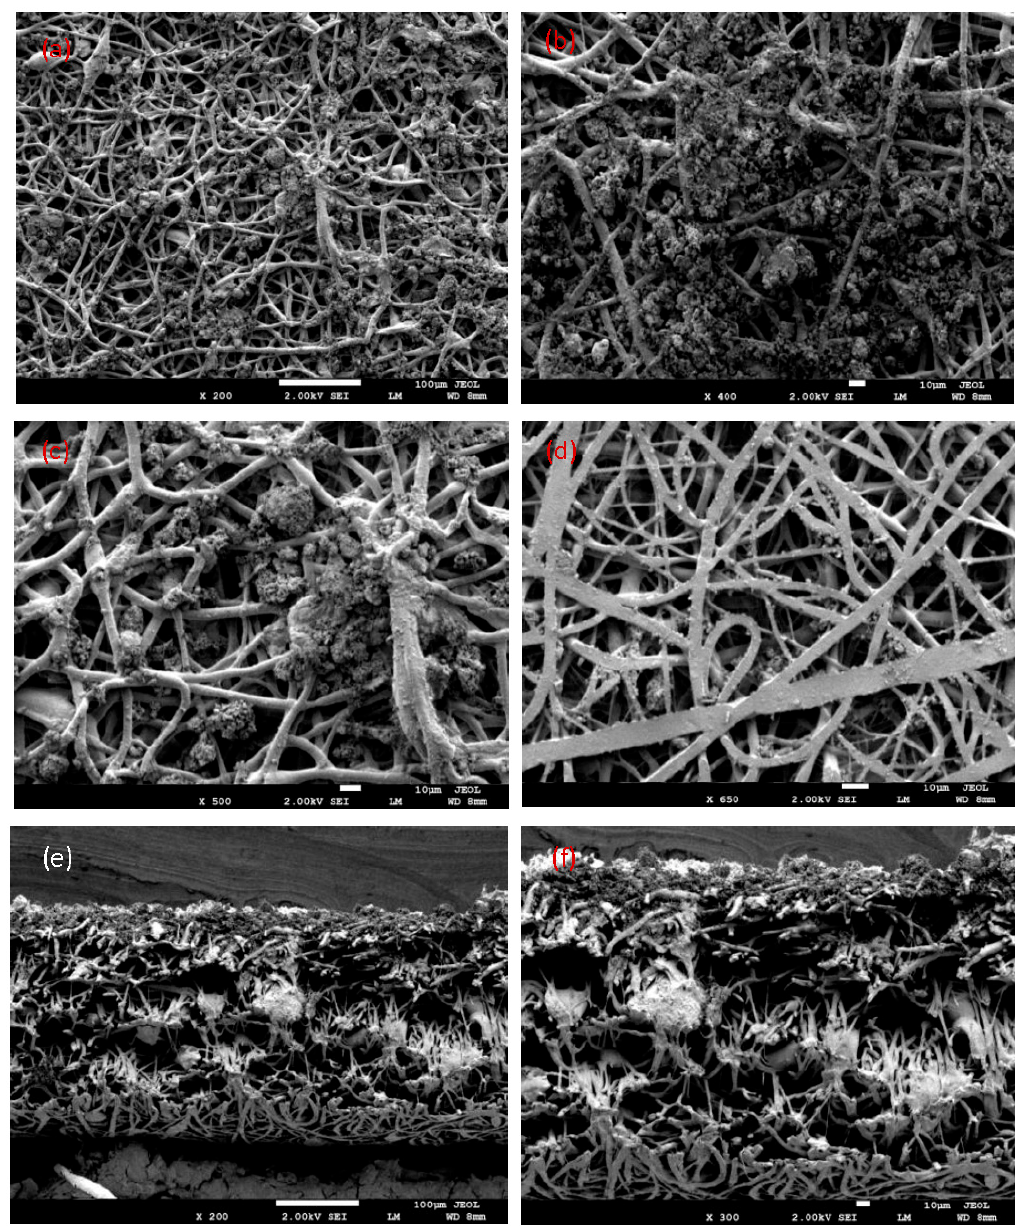
Figure 8. SEM images of nanoparticles and microparticles of clays from the Saudi soil at the surface of the membrane after the filtration process; ( a , b , c ) Top of the membrane layer with cylindrical fibers; ( d ) The bottom membrane layer with flat fibers; ( e , f ) Cross-section of the membrane with different scales.